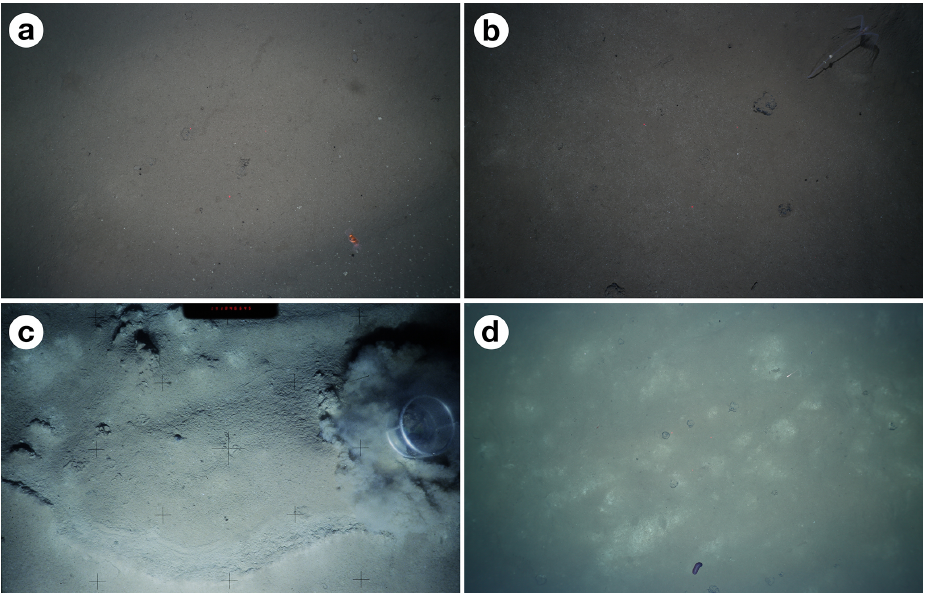
Figure 4. Example images of datasets DS A –DS D , with platform information and mean image footprints as follows. (a) DS A – OFOS – 4.9m 2 . (b) DS B – OFOS – 5.7m 2 . (c) DS C – OFOS – 12.5m 2 . (d) DS D – OFOS – 22.5m 2